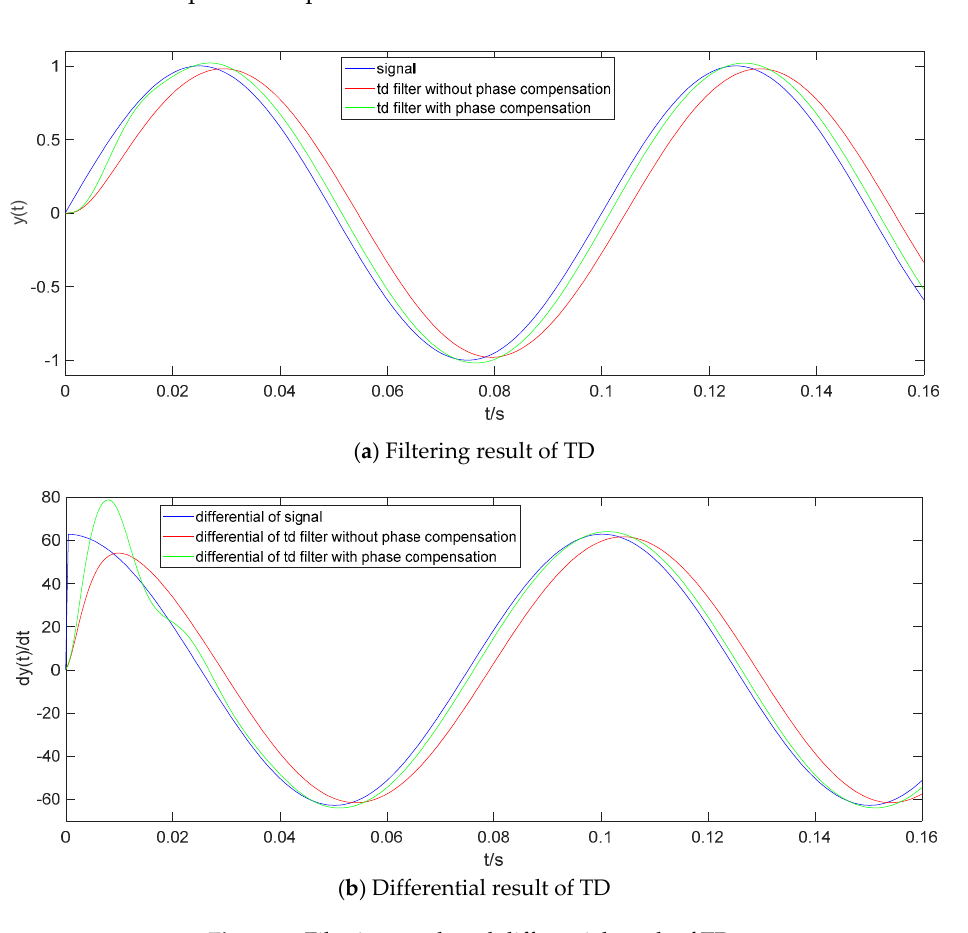
Figure 2. Filtering result and differential result of TD.